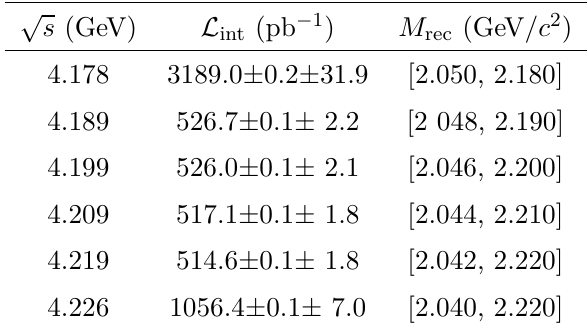
Table 2 . The integrated luminosities ( L int ) and the requirements on M rec for various center-of- mass energies. The first and second uncertainties are statistical and systematic, respectively. The definition of M is given in eq. rec